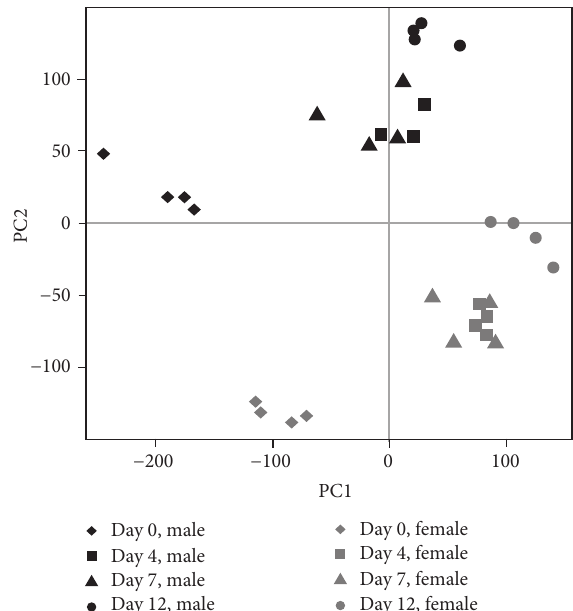
Figure2:2DsnapshotofPCAanalysisofsampledistributionsbased on all genes. The day 0 samples were well separated from the day 12 samples indicating dramatic transcriptomic changes during the dedifferentiation process. Moreover, the day 4 and day 7 samples were close together indicating small-magnitude transcriptomic changes between days 4 and